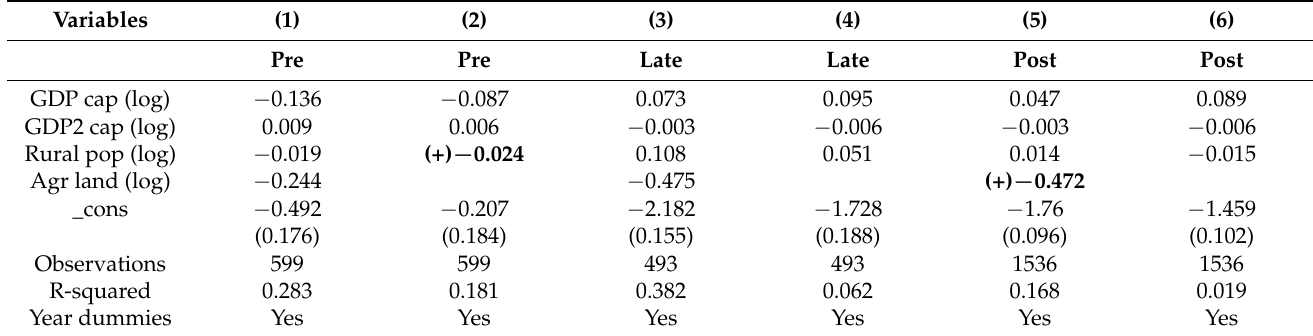
Table A11. Long-run results, forest transition